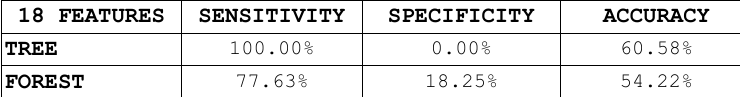
Table 9. One color slope value